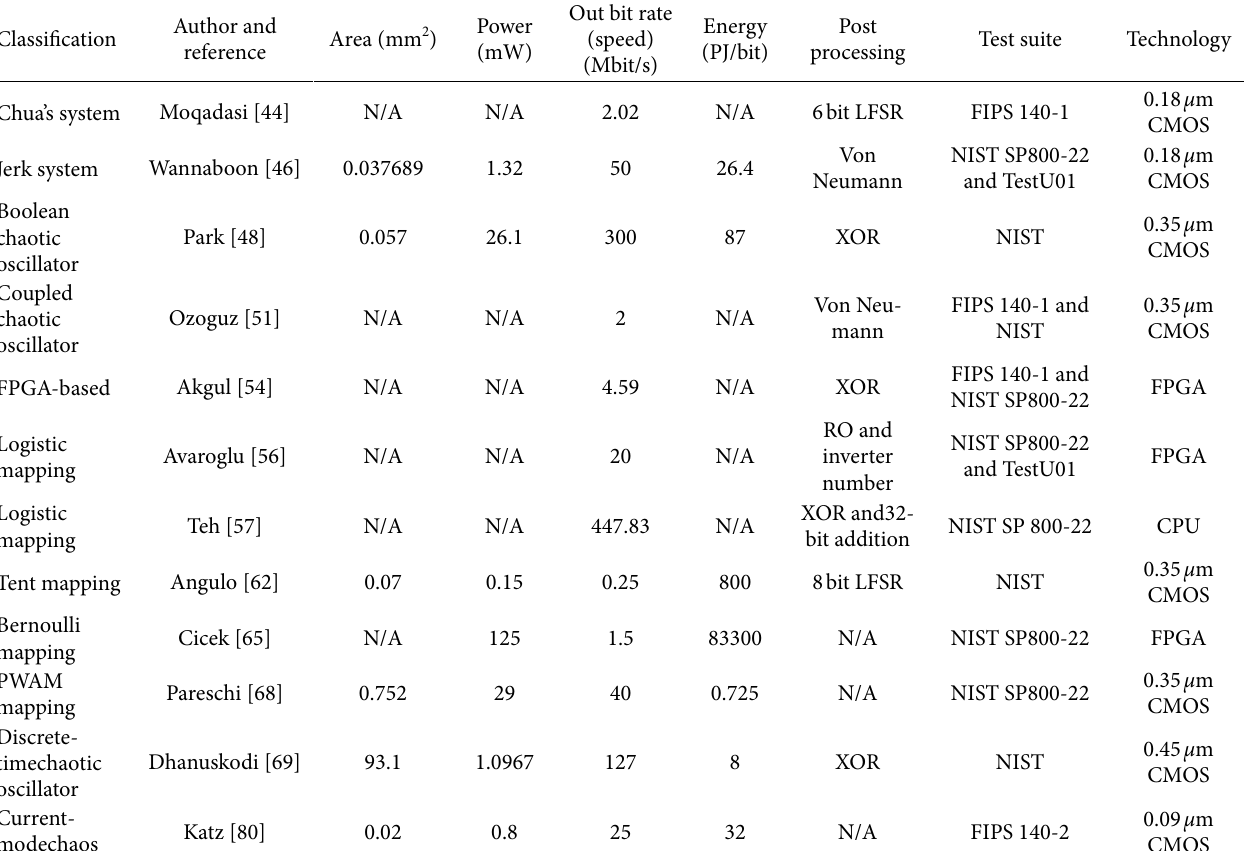
Figure 8: A graph of the reviewed methods for the TRNGs based on chaos. Table 1: Summary of TRNGs methods based on